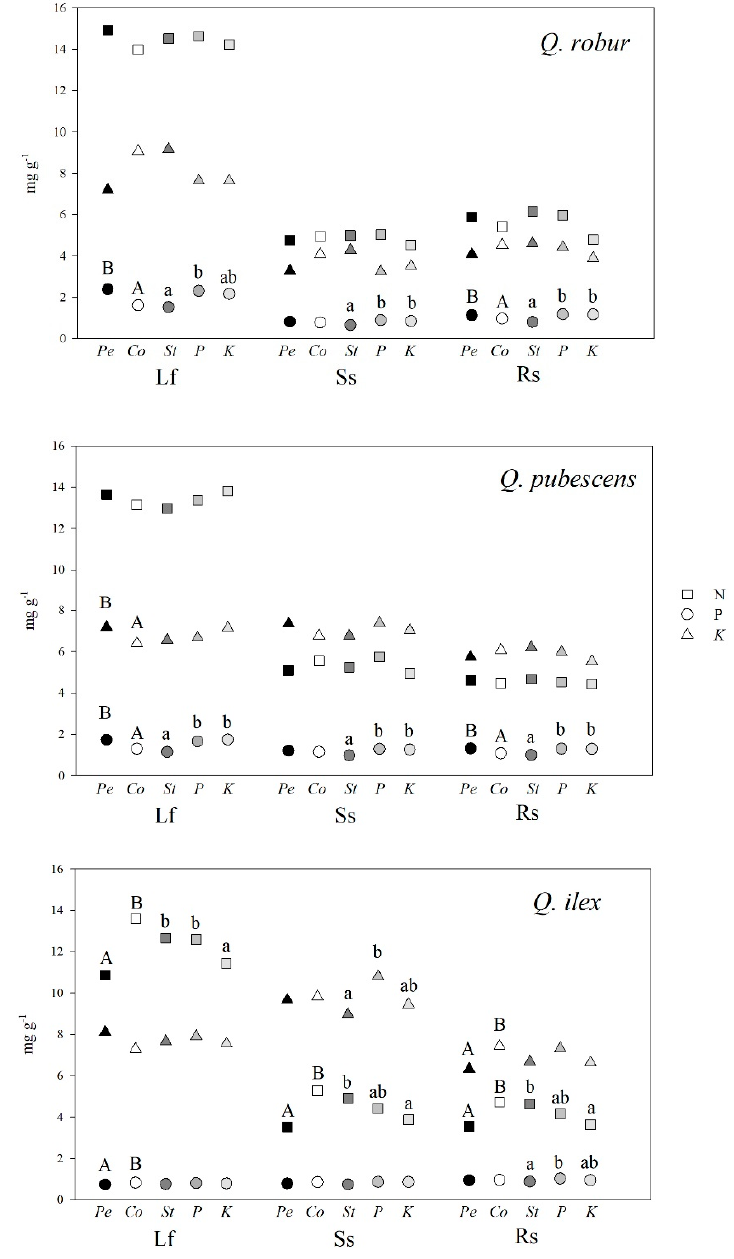
Figure 2. Macro-element concentration (mg g − 1 for N, P, K) in leaves (Lf), shoot (stem, Ss), and root-system (Rs) analyzed for substrate and fertilization (mean ± SD). Source of variation substrate ( S ), fertilization ( F ), and their interaction ( S × F ). Capital letters and lowercase letters indicate homogenous groups for S and F , respectively. Pe = Peat; Co = Coir; St = Standard fertilization; K = K-enriched fertilization; and P = P-enriched fertilization.